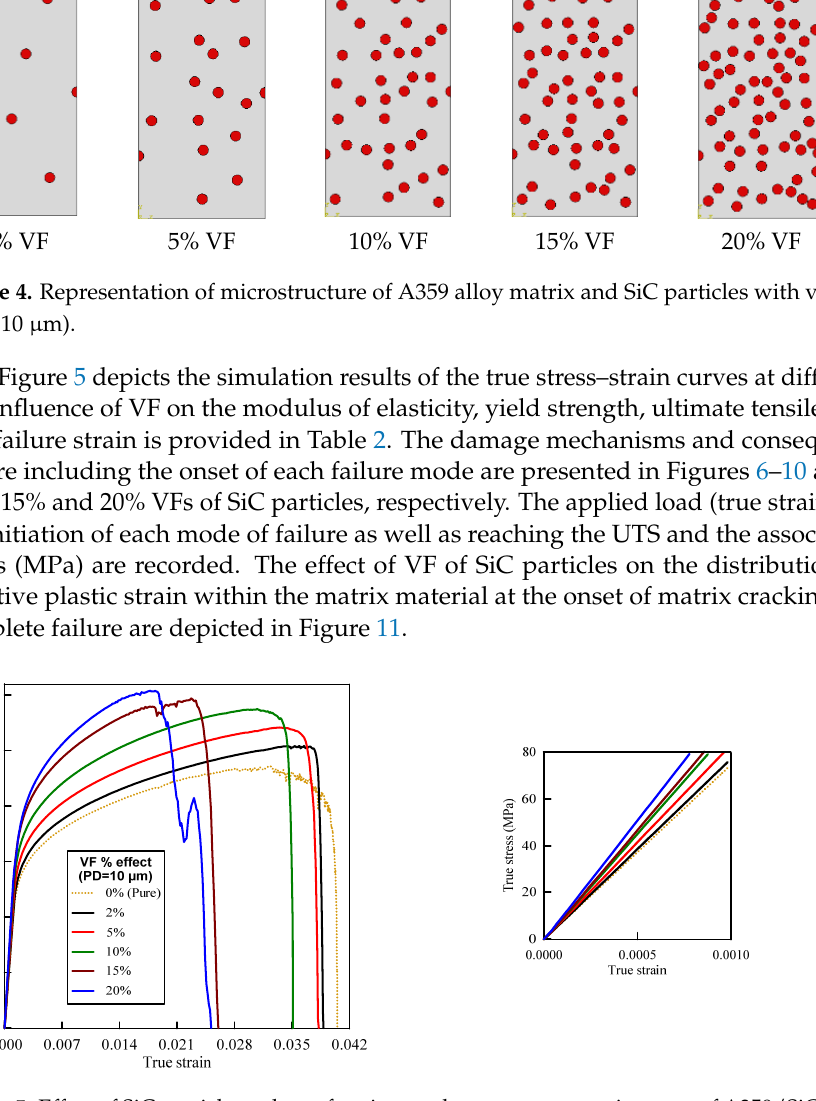
Figure 5. Effect of SiC particles volume fraction on the true stress–strain curve of A359/SiC composite (particle size (PS) = 10 µm). Table 2. Effect of SiC particle volume fraction on the mechanical properties of A359/SiC composites (PS = 10 µm). Property Modulus of elasticity (GPa)